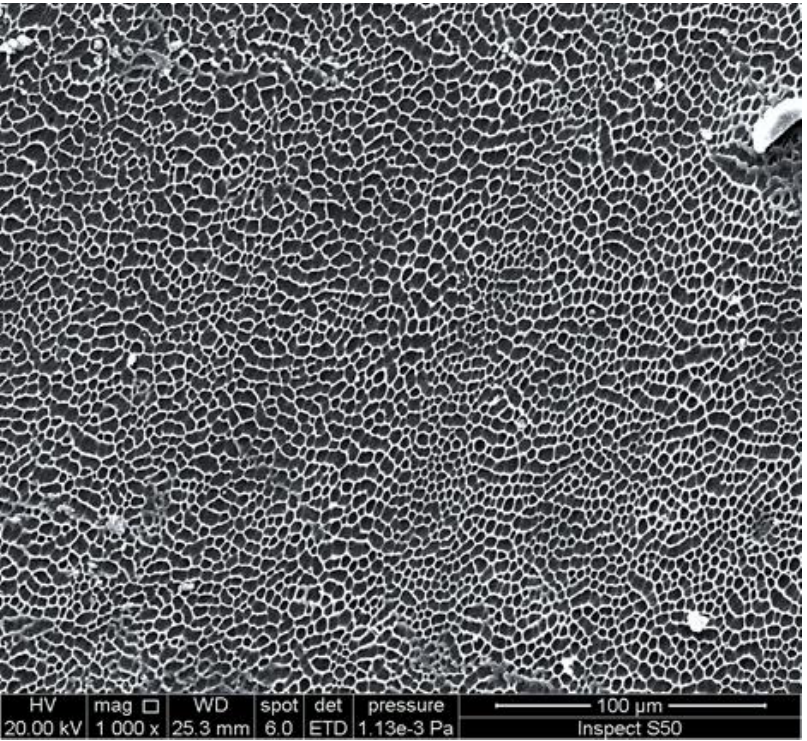
Figure 7. SEM image of the surface of an irradiated PVC film blended with a 4-methoxybenzoic acid-Sn complex. acid-Sn